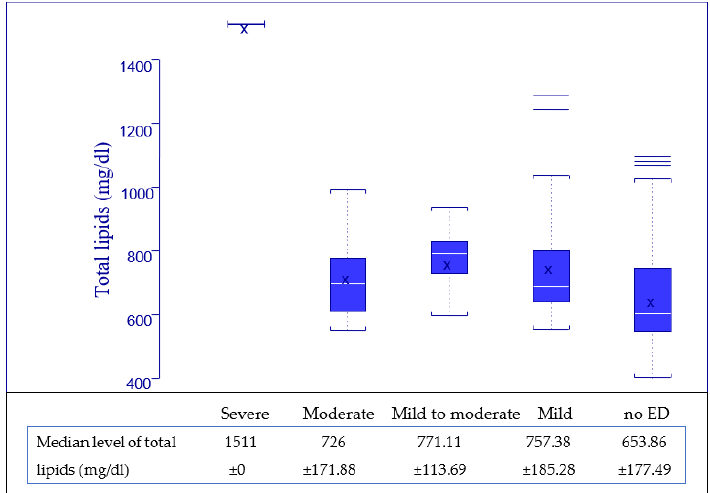
Figure 7. Distribution of total lipids related to erectile function categories (Table 1).